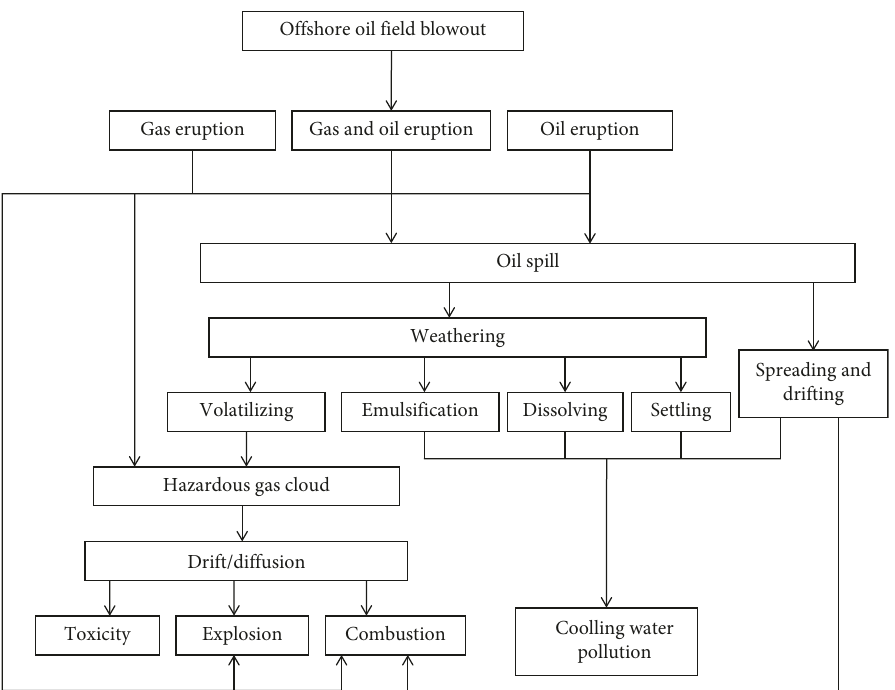
Figure 2: Direct, secondary, and derived hazards from the blowouts of offshore oil